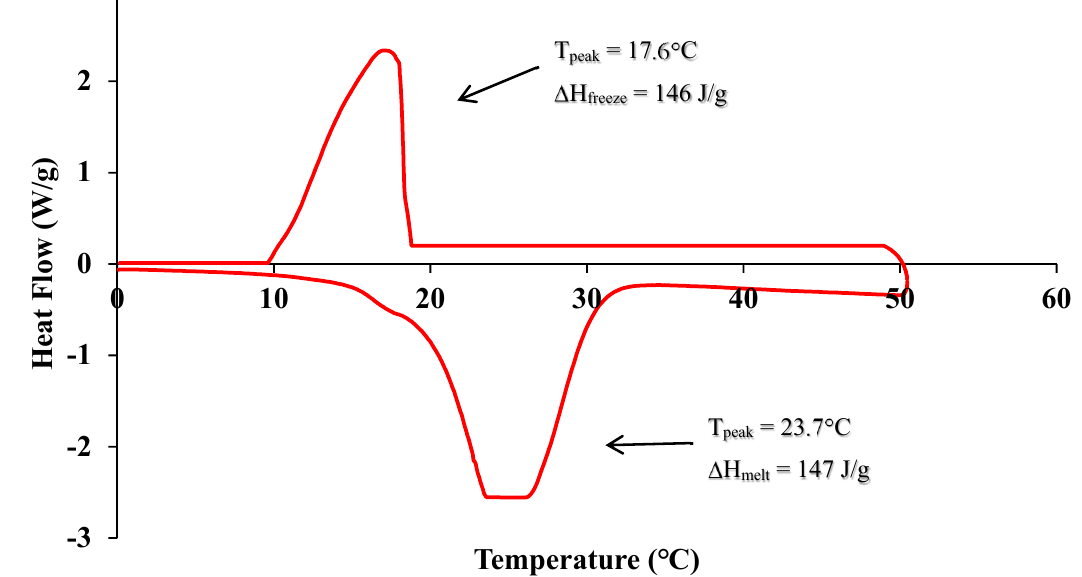
Figure 11. Differential scanning calorimeter (DSC) graph of phase change materials (PCM) used in this study.